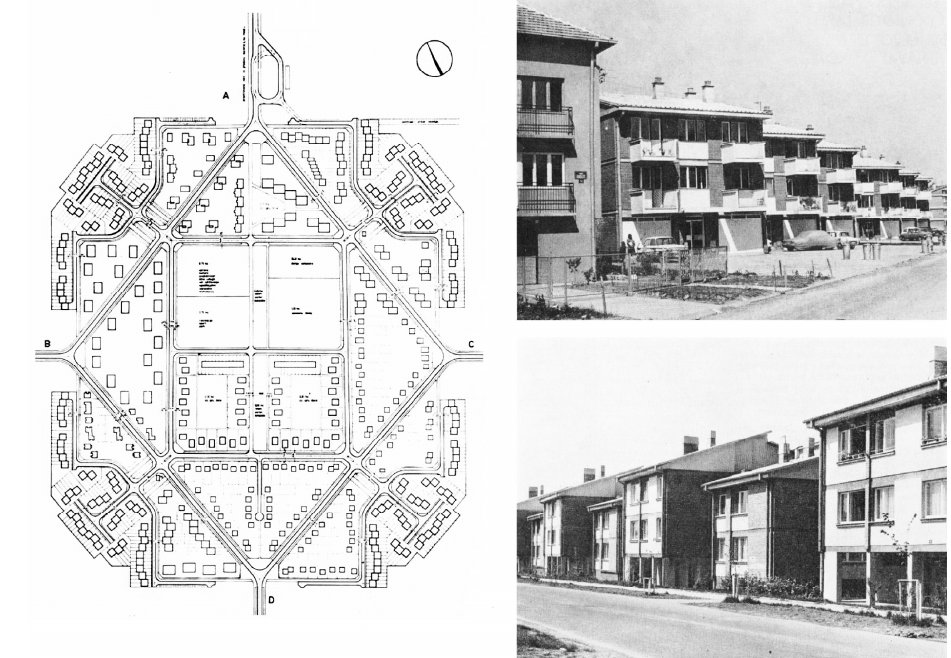
Figure 4. Detailed urban plan of the settlement Koteži, Arch. D. Barlovac ( left ), realization of Kotež in 1975 ( right ). Source: [61].